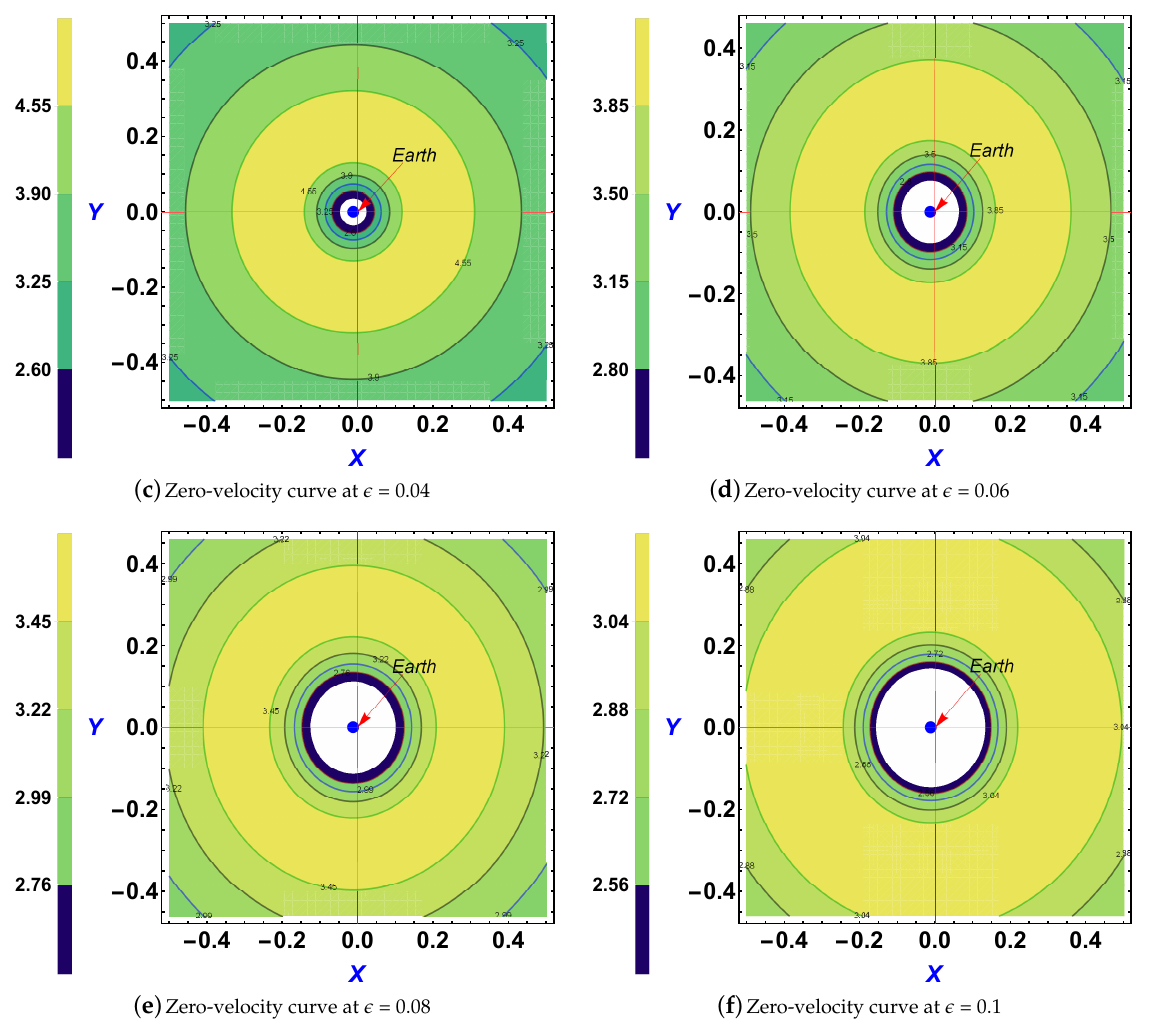
Figure 3. Variation in zero-velocity curve near the Earth due to the effect of the continuation fractional potential parameter (cid:101)